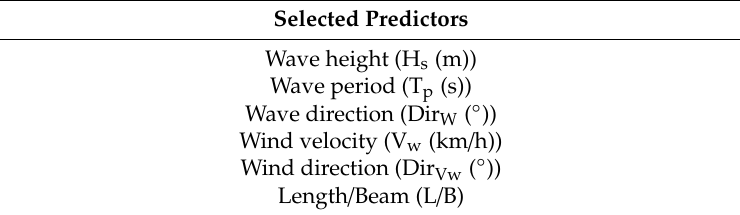
Table 7. Predictors involved in fitting regression models.